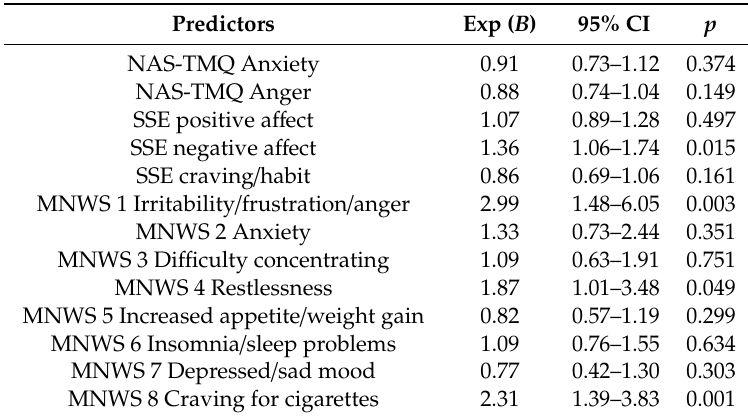
Table 3. Binary logistic regression analysis of subscales and specific symptoms predicting smoking relapse at the 3 month